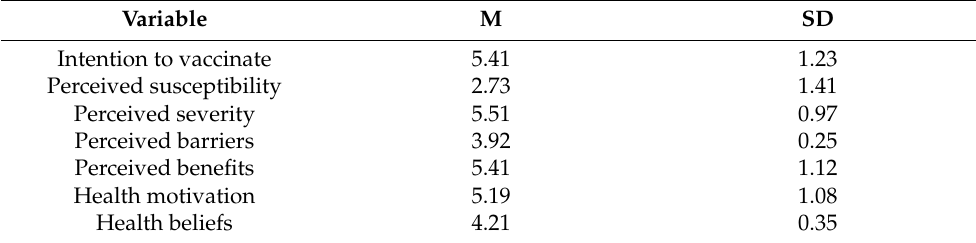
Table 1. Means and standard deviations of the research